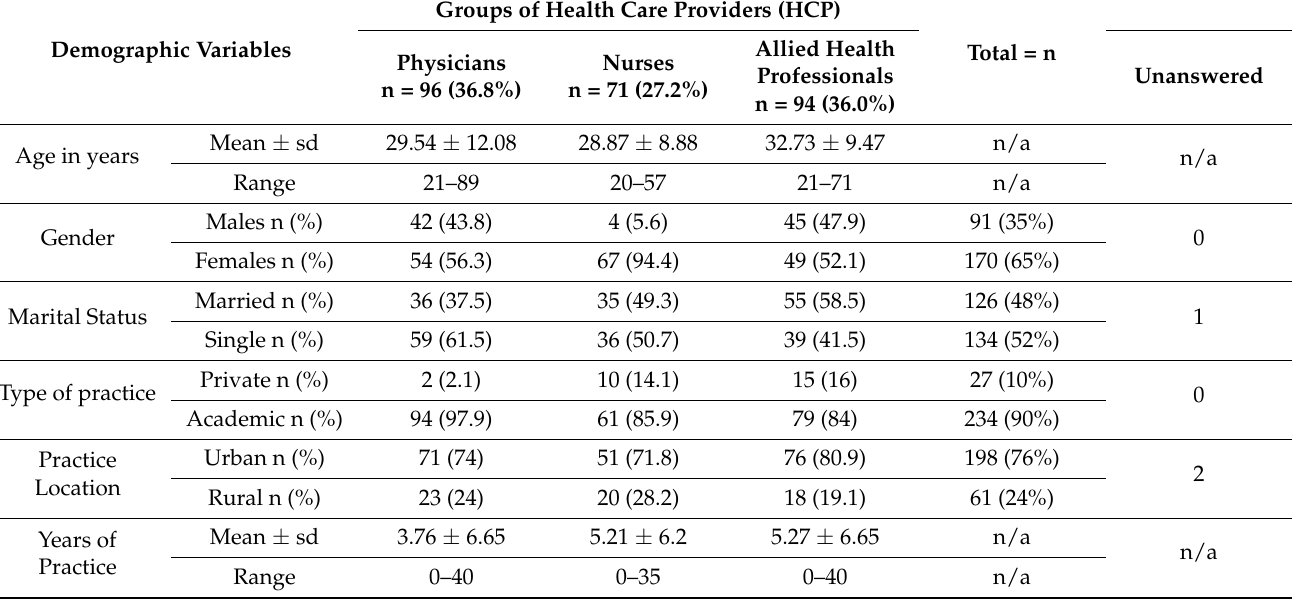
Table 1. Demographic characteristics of study